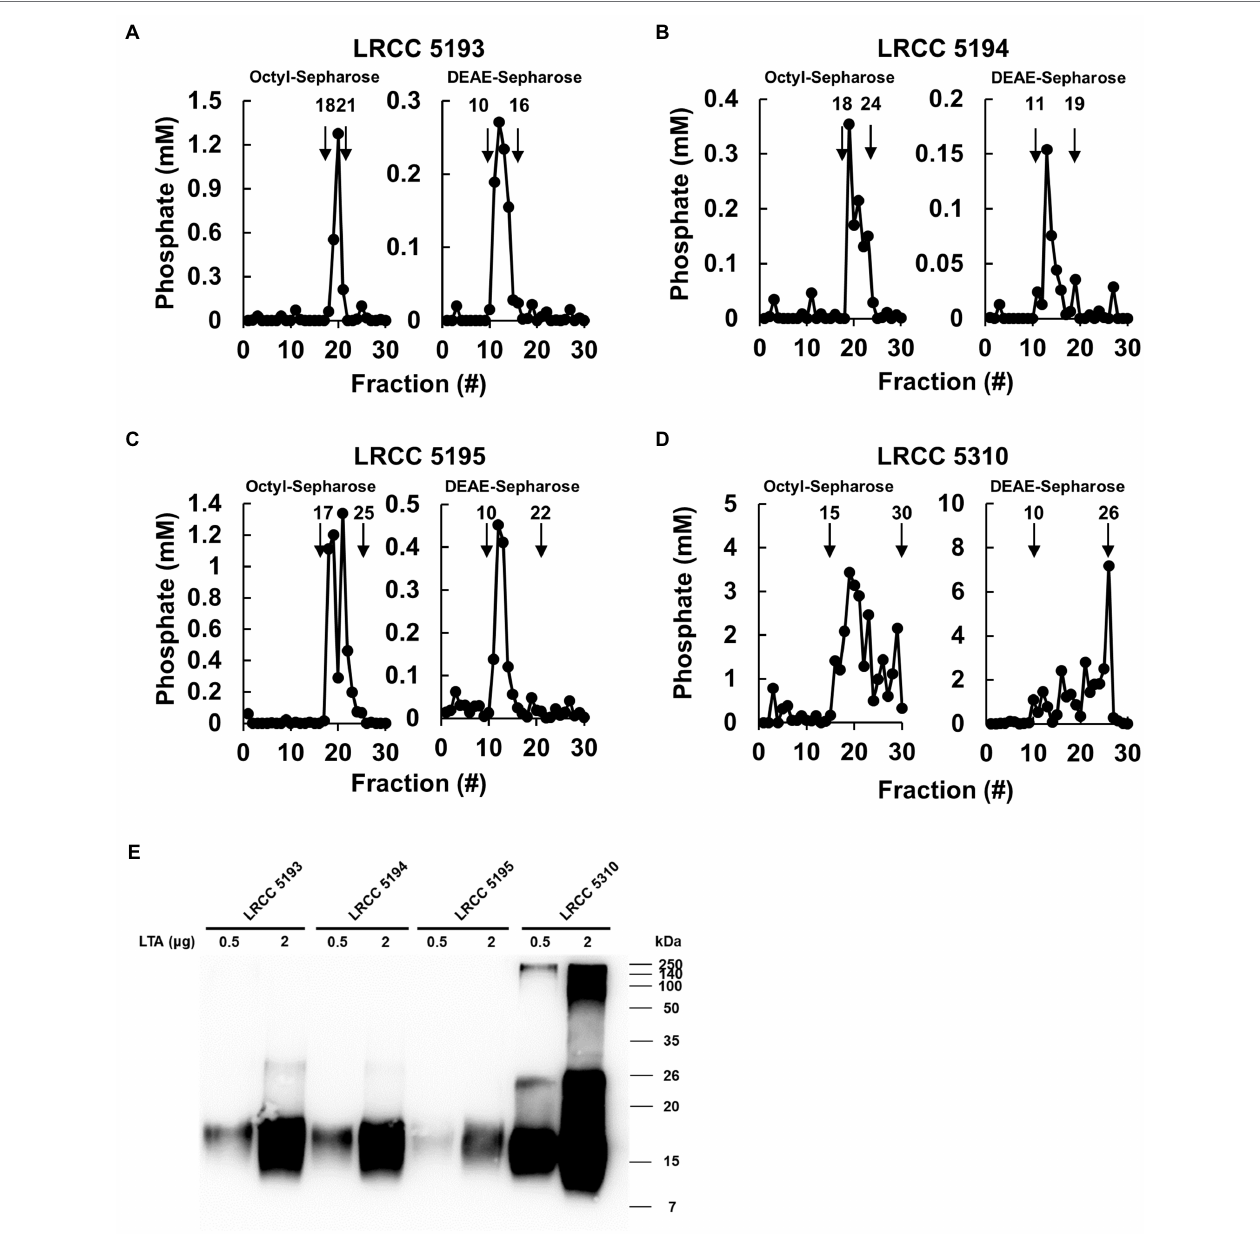
FIGURE 1 | Elution profiles and molecular characteristics of LTAs purified from four different strains of L. plantarum . (A–D) LTAs were purified from four different strains of L. plantarum by sequential application of butanol extraction, hydrophobic interaction chromatography, and ion-exchange chromatography. Inorganic phosphate assays were then performed to measure the quantity of LTAs in each fraction after hydrophobic interaction chromatography (Octyl-Sepharose, left) and ion-exchange chromatography (DEAE-Sepharose, right) as described in Materials and Methods. (E) Purified LTAs were subjected to Western blot analysis using antibody specific for